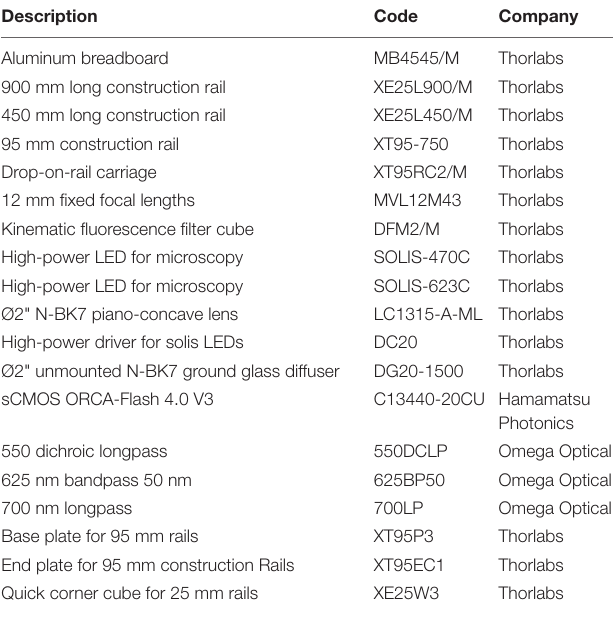
TABLE 1 | MULTIPLE Optomechanical components